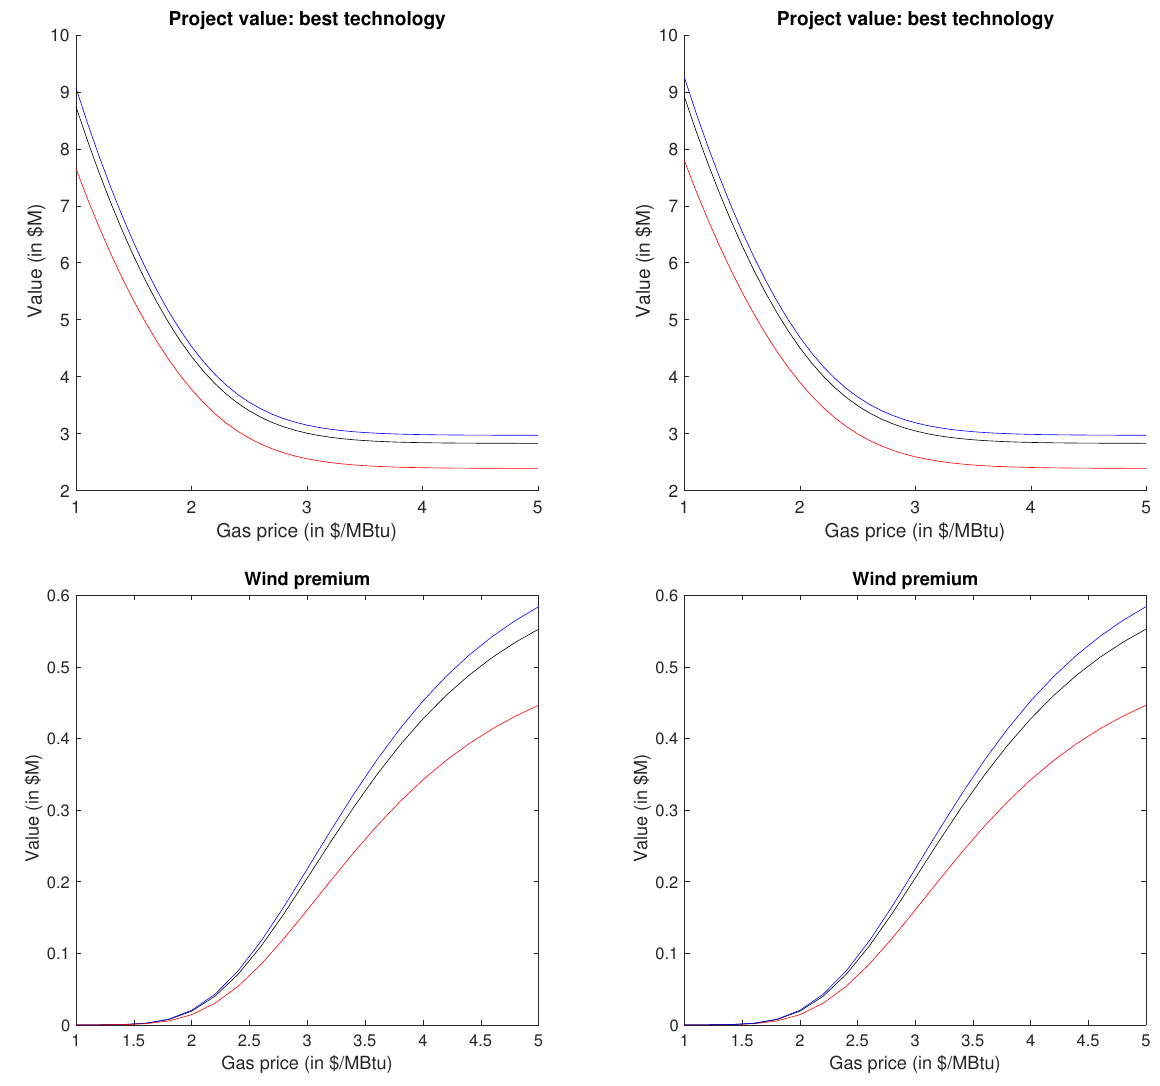
Figure 10. This figure displays the effects of parameter A on the project value (upper panels) and wind premium (lower panels) at t = 0 in case of low sensitivity of the gas price ( C = 0, left panels) and of high sensitivity ( C = 2.5, right panels). The value of X 0 is 50$/MWh. The values of A are: A = 0.1 (blue), A = 0.5 (black), A = 2 (red). Other parameter values are given in Table 1; the investment horizon is T = 1